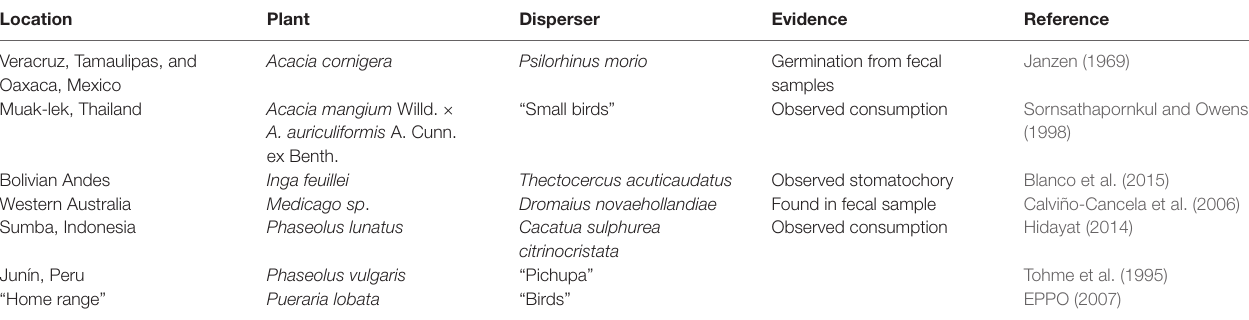
TABLE 1 | Examples of bird dispersal in